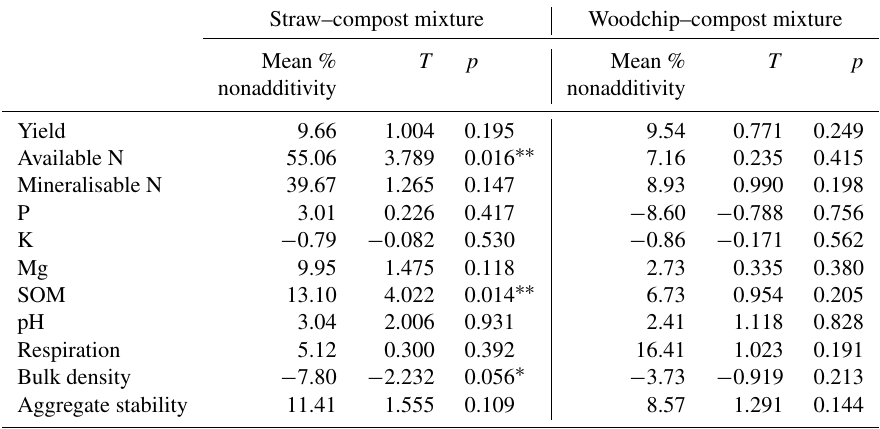
Table 4. Statistical outputs of one-tailed T tests of nonadditive effects. Significance of deviation from additivity (0) is indicated as ∗∗ p< 0 . 05 and ∗ p< 0 . 1. Straw–compost mixture Woodchip–compost